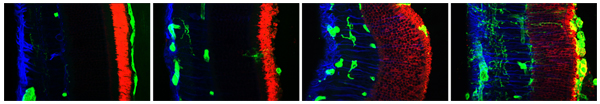
Retinal detachment. One image per class (normal, 1 day after detachment, 3 days, 7 days).